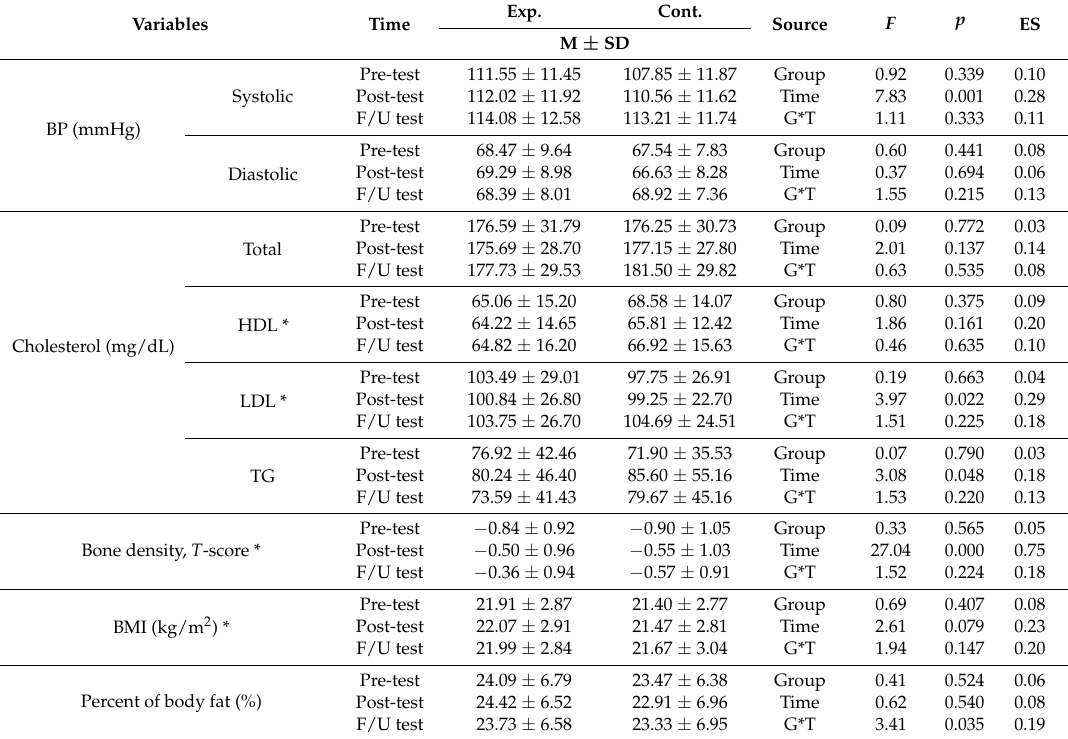
Table 3. Group comparisons of physiological health at pre-, post-, and follow-up test.